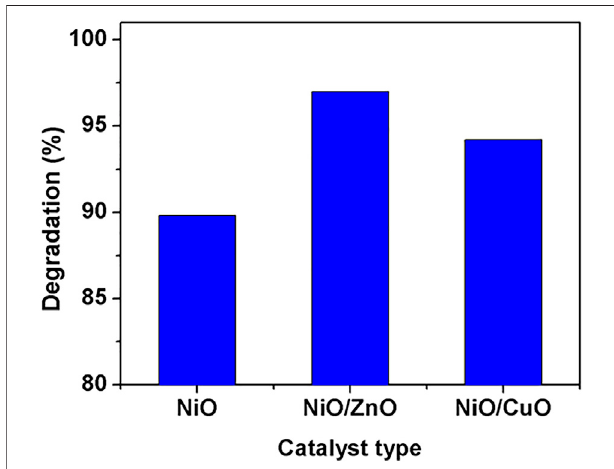
FIGURE 9 | Effect of the catalyst type on the degradation of MB dye.